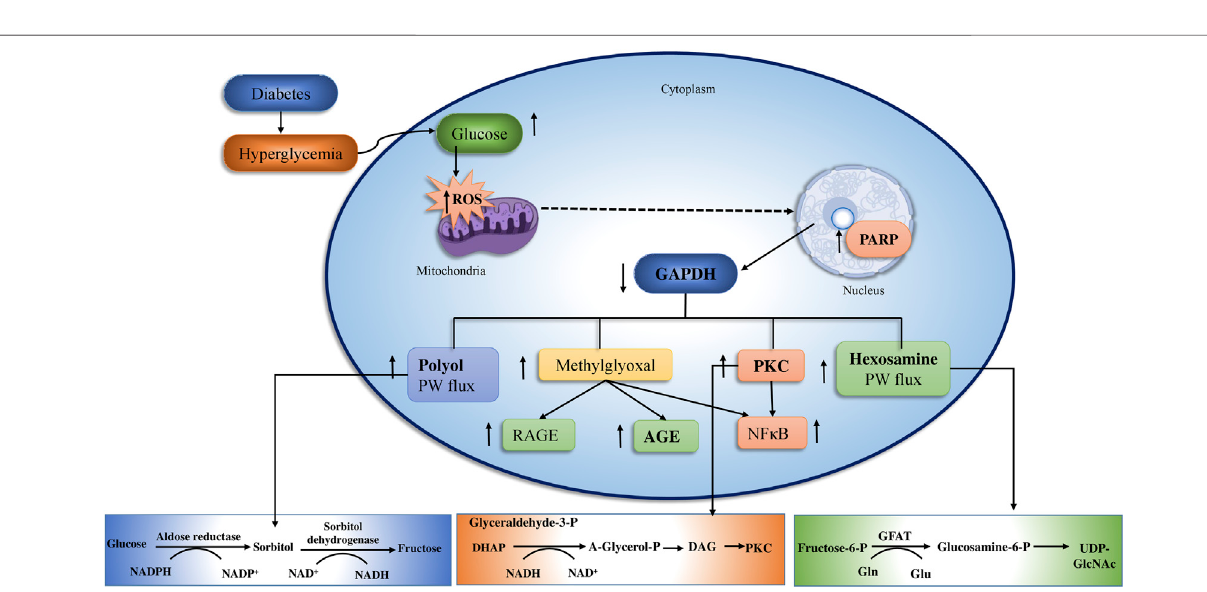
Frontiers in Pharmacology |